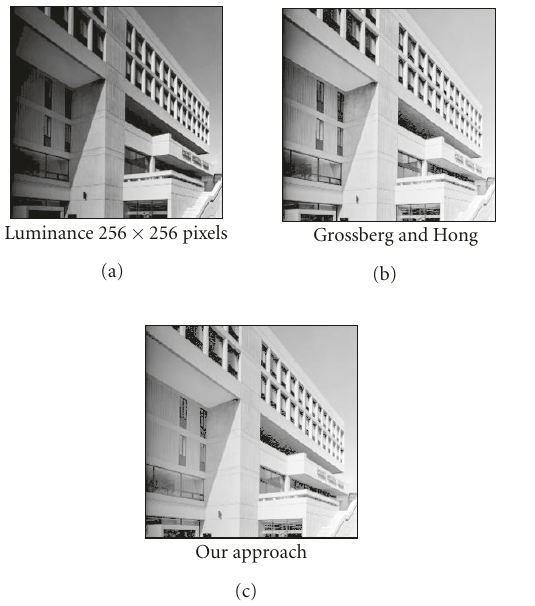
Figure 9: MIT image with overlying luminance ramp : the origi- nal MIT image (see Figure 8) was multiplied with a luminance ramp which linearly increases from left (intensity 0) to the right (intensity 1).